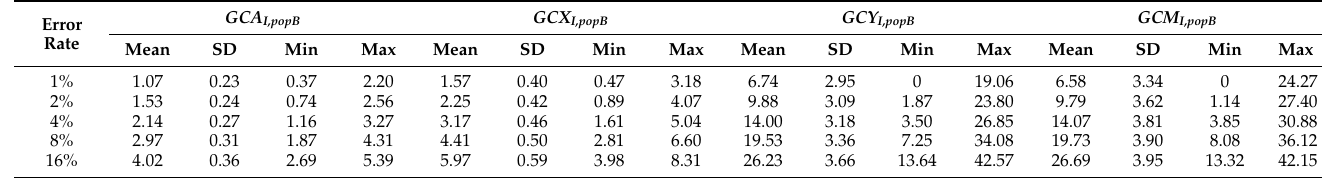
Table 4. Effects of pedigree errors (RMSE × 10 3 ) on calculating the average genetic contributions to G8 1